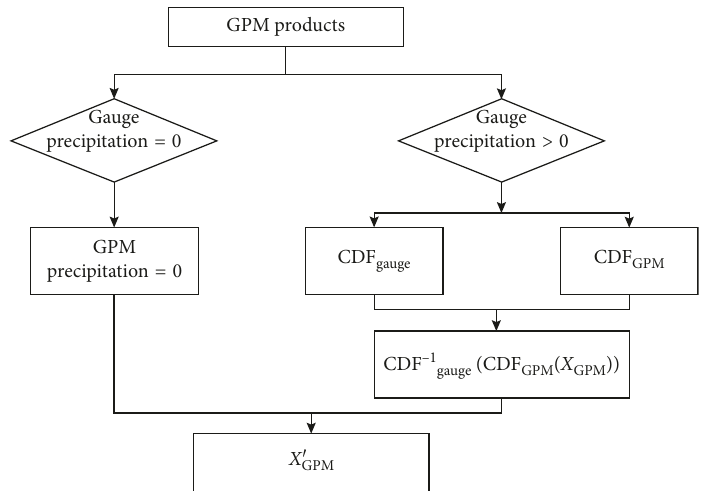
Figure 2: Flowchart of the CDF model for precipitation correction.